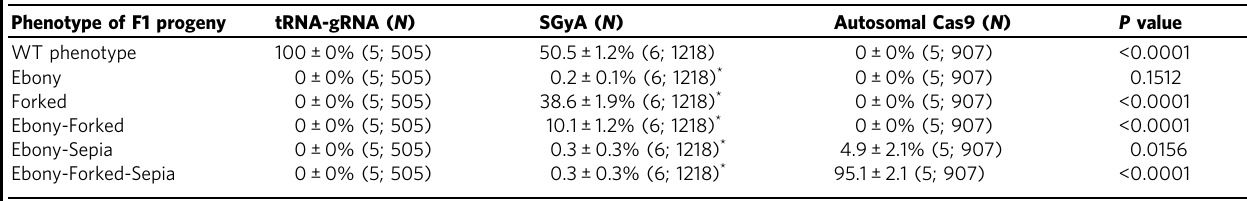
Table 1 ANOVA comparisons of cleavage activity among experimental groups.